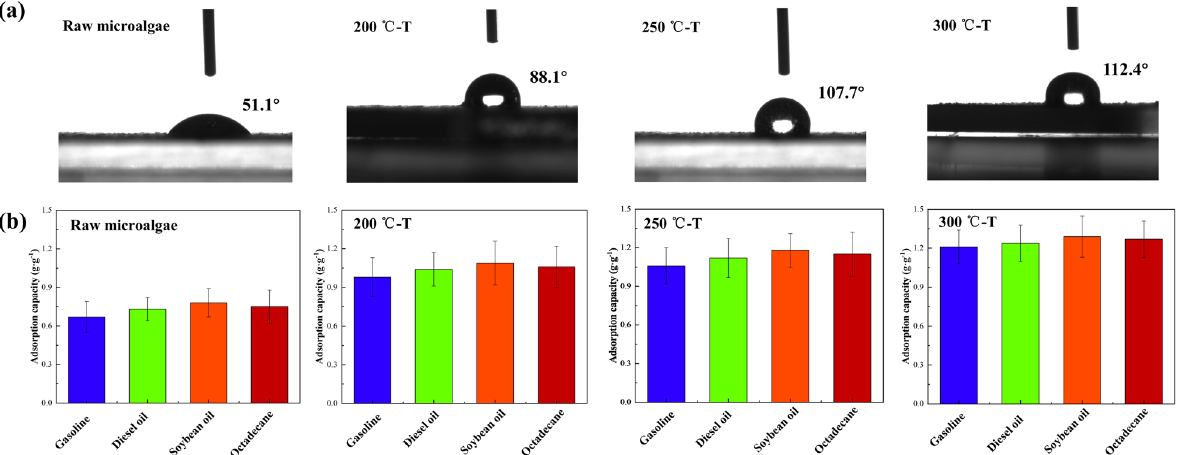
Fig. 3 Hydrophobicity of raw and microalgal biochar ( a ), and oil adsorption capacity of raw and microalgal biochar ( b ) under different torrefaction